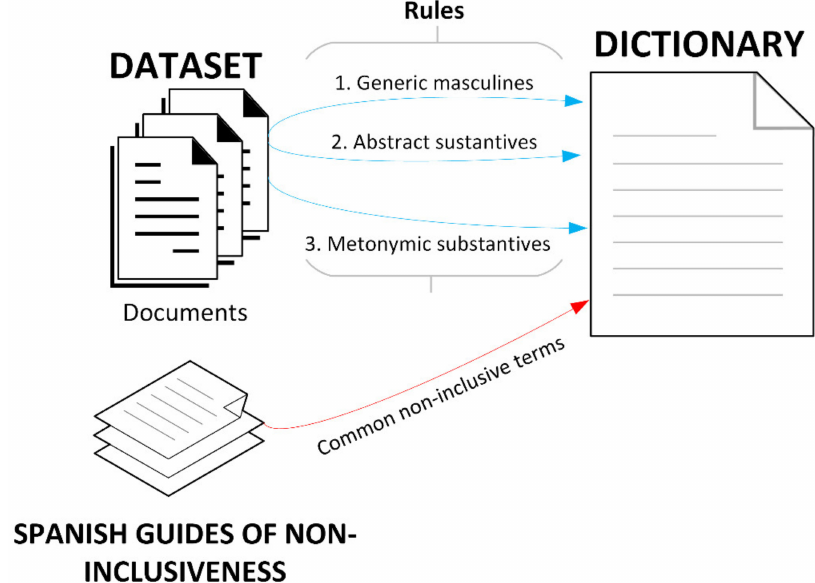
Figure 8. Generation of the dictionary of potential non-inclusive terms.